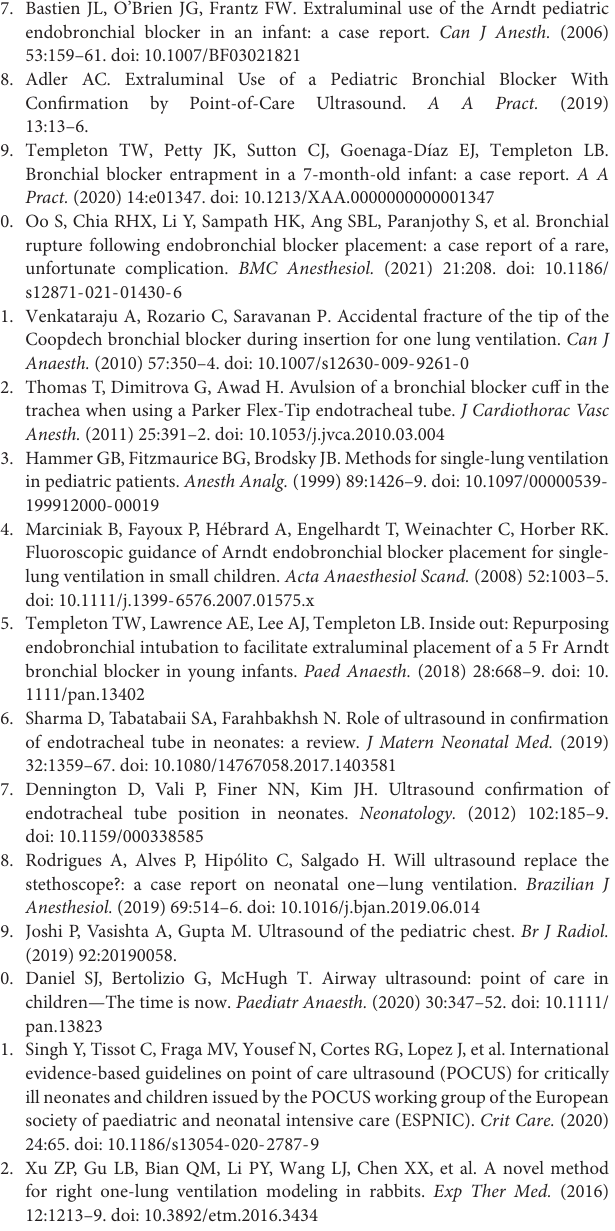
Supplementary Figure 1 | Flexible fibreoptic bronchoscope view with the glottis intubated with a single lumen tube and the extraluminal approach of the bronchial blocker.